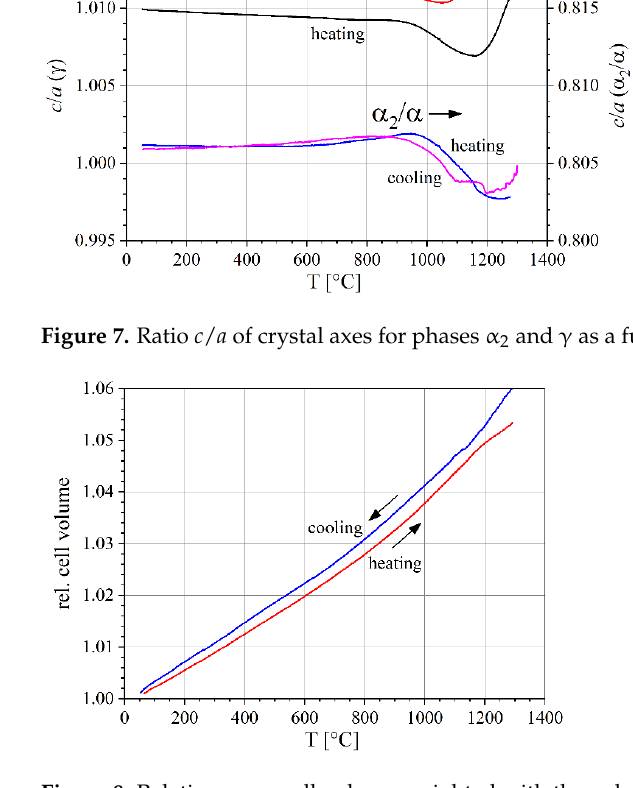
Figure 8. Relative mean cell volume weighted with the volume fractions of the three phases during heating and cooling (see text).